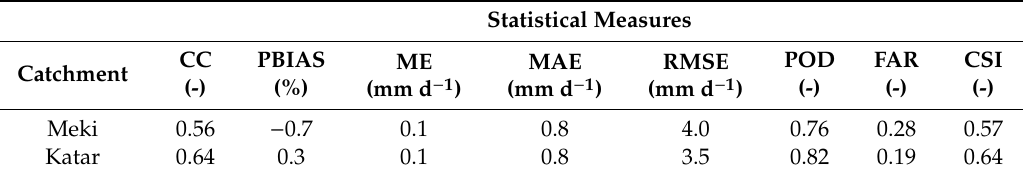
Table 5. Daily catchment average rainfall comparison between the bias-corrected CHIRP satellite and the rain gauge dataset after bias correction from 1985–2000.